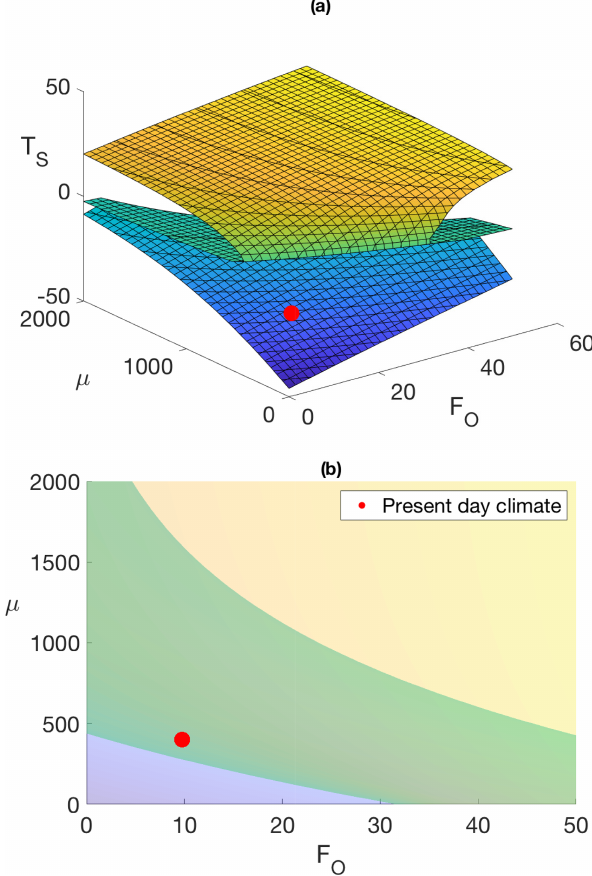
Figure 5. Energy balance model of the modern Arctic. Parameter values are as in Table 1. The red dots locate today’s Arctic climate conditions. Ocean heat transport F O increases from 0 to 50Wm − 2 and carbon dioxide concentration µ increases from 0 to 2000ppm. (a) 3-D plot of equilibrium manifold. (b) Projection on the (F O ,µ) parameter